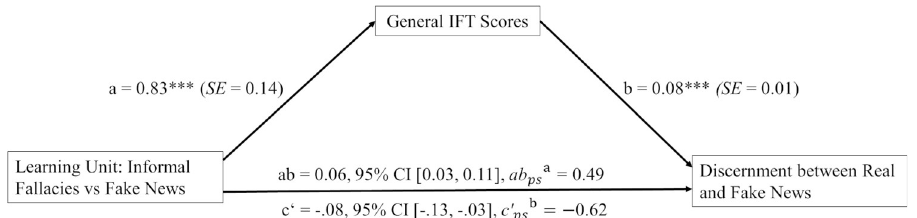
Fig 2. Mediation model with received learning intervention as antecedent, IFT explanation task as mediator and discernment scores as consequent. The graphic shows the mediation model concerning H1 (a), H2 (ab) and H3 (ab +c’). Intervention was dummy-coded with 1 = receiving the informal fallacy intervention and 0 = receiving the fake news intervention. Coefficients presented are unstandardized. For direct and indirect effect no NHST was conducted but instead Bootstrap-CIs are reported. *** p < .001. 1 ab = partially standardized effect size for the indirect effect. 2 ps c’ ps‘ = partially standardized effect size for the direct